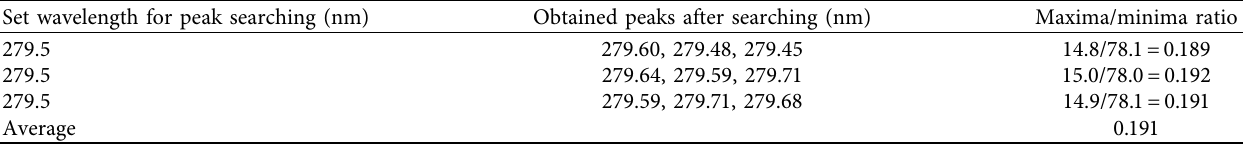
Table 4: Resolution studies.